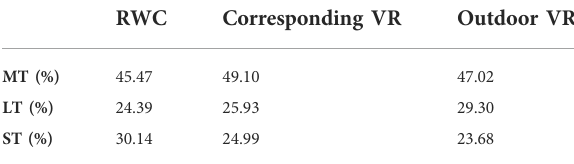
TABLE 2 Distribution of adjustment strategies of step length (mixed (MT), lengthening (LT), and shortening (ST) trials) in the three experimental conditions (RWC: real-world condition; VR: virtual